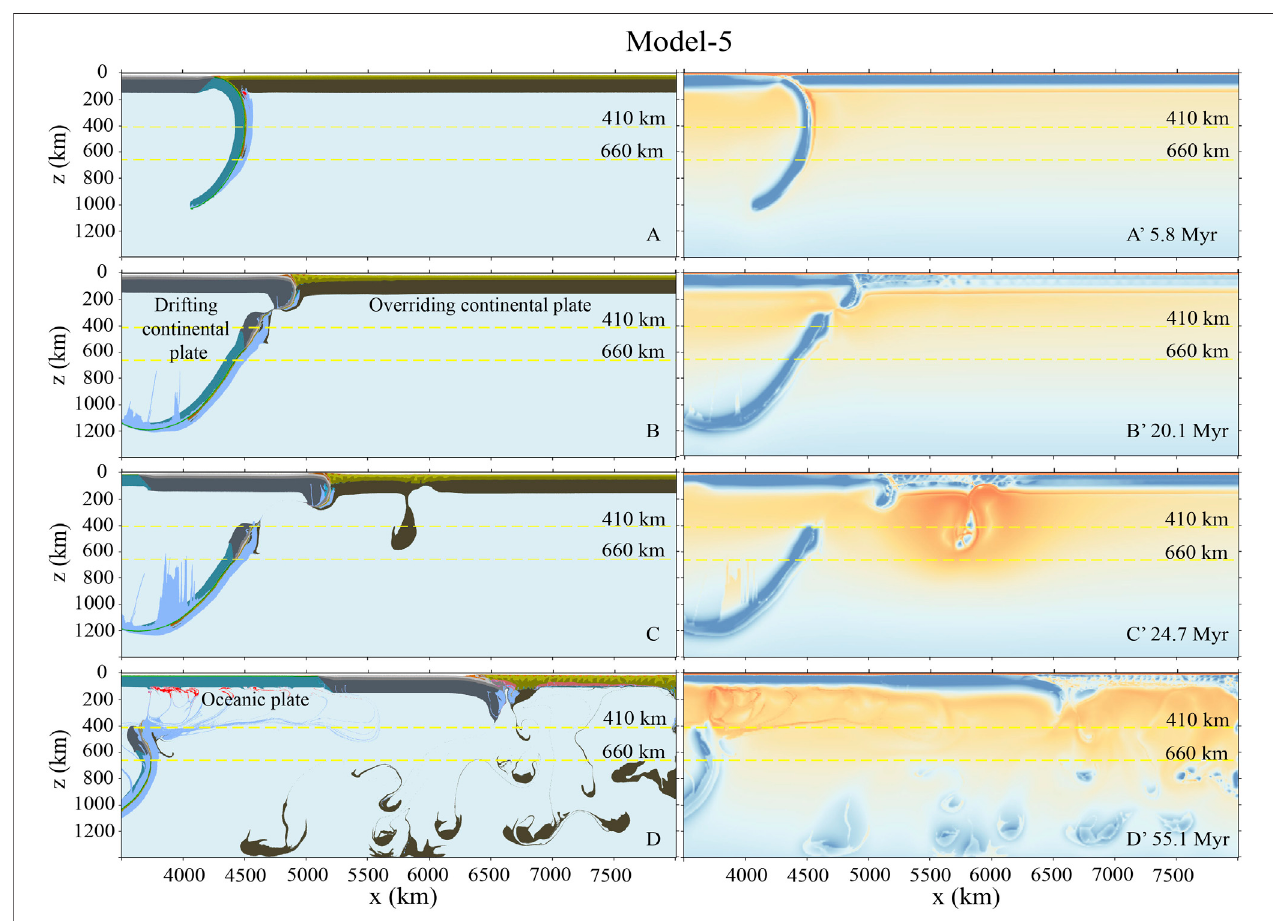
FIGURE 7 | Model-5 evolution with weakest overriding plate. The plastic friction coef fi cient of the overriding lithospheric mantle is initially λ · sin ( φ ) (cid:2) 0.01 and will decrease linearly to 0.001 with accumulated plastic strain to ε plas = 1 ( Supplementary Table S2 and SupplementaryEquation S11 in the supporting information). All the other parameters are identical to Model-4 ( Figure 6 ). (A – D) The composition fi eld evolution with the corresponding colorbar is shown in Figure 2A . (A ’ – D ’ ) The effective viscosity evolution with the corresponding colorbar is shown in Figure 2B .